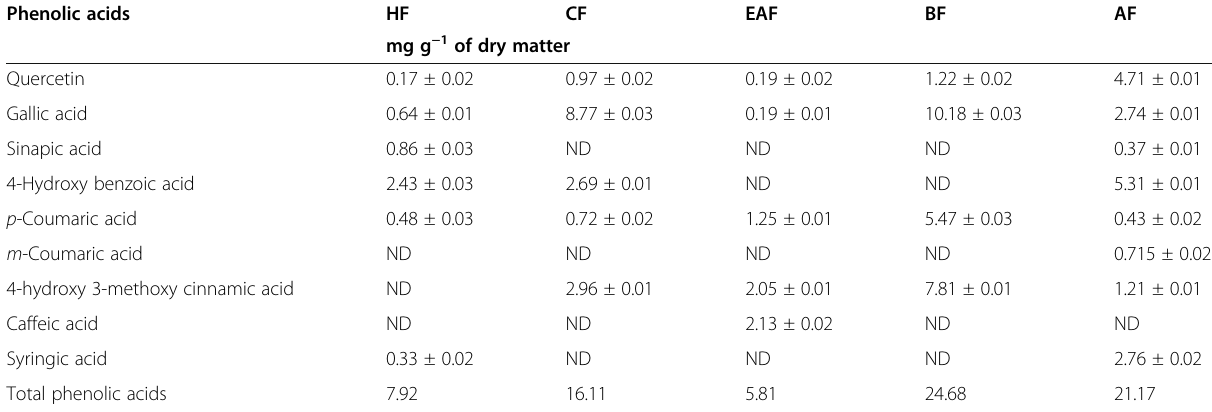
Table 2 Phenolic compounds in solvent extract fraction of Moringa oleifera analyzed through reversed-phase high-performance liquid chromatography (RP-HPLC) Phenolic acids